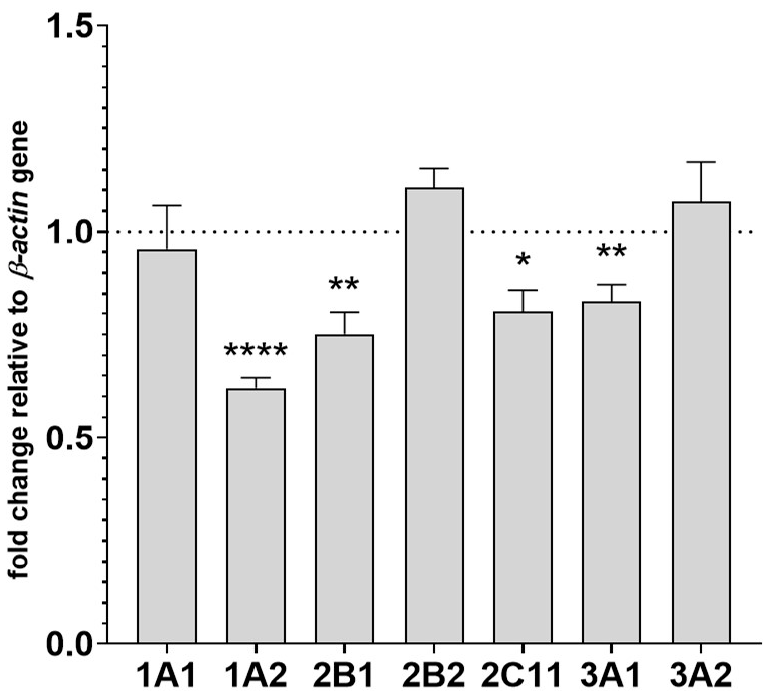
Figure 3. The effect of chronic treatment with asenapine on the mRNA levels of CYP1A1, CYP1A2, CYP2B1, CYP2B2, CYP2C11, CYP3A1 and CYP3A2 genes in the liver. The results are expressed as the fold-change in relation to the beta-actin housekeeping gene. All the values are the mean fold-change calculated by the comparative delta-delta Ct method for the control and asenapine-treated groups. All values are the means ± S.E.M. ( n = 12). The results were calculated using Student’s t -test. Statistical significance is shown as * p < 0.05, ** p < 0.01, **** p < 0.0001 vs. control